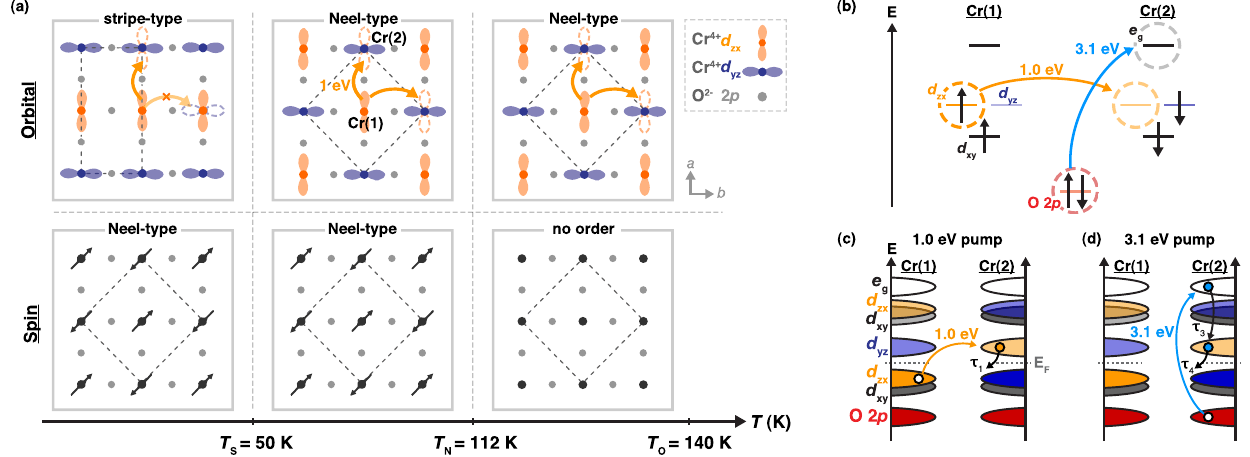
Fig. 1 Spin and orbital order in α -Sr 2 CrO 4 . a Schematic diagrams of the spin- and orbital-ordered ground state in α -Sr 2 CrO 4 , showing different types of antiferro-type spin ordering and d yz / d zx orbital ordering. We note that the four-lobed shapes of the d -orbitals are projected into the ab -plane. Arrows indicate possible 1 eV transitions from occupied ( fi lled shapes) to unoccupied (dotted shapes) orbital states in a given ordered phase; transitions from Cr(1) to Cr(2) ions are shown for simplicity, but the reverse can also occur. b Energy ( E ) levels and orbital structures on neighboring sites with Cr(1) and Cr(2) ions at a temperature ( T ) below the Néel temperature ( T N ): T ≤ T N . The d - d transitions between d zx orbitals from Cr(1) to Cr(2) (or between d yz orbitals from Cr(2) to Cr(1)) correspond to hopping energies of 1.0 eV. 3.1 eV excitation drives a charge-transfer-type transition from O 2 p to Cr e g orbitals. The relevant electronic structures are displayed along with photoexcitation at ( c ) 1.0 eV and (d) 3.1 eV. On-site transitions from O 2 p to Cr e g states are possible at both Cr(1) and Cr(2)